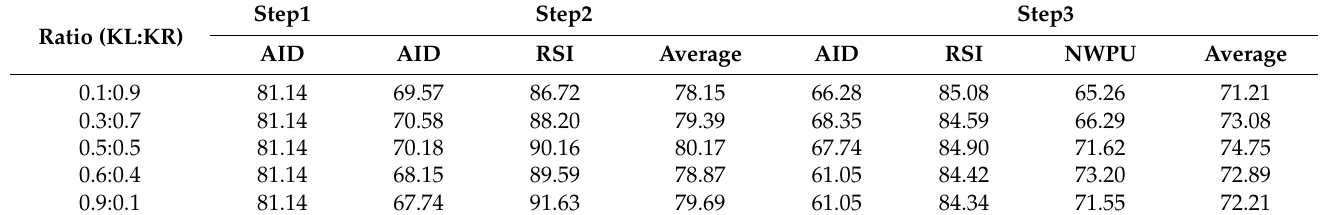
Table 2. The influence of different module weights on model accuracy.